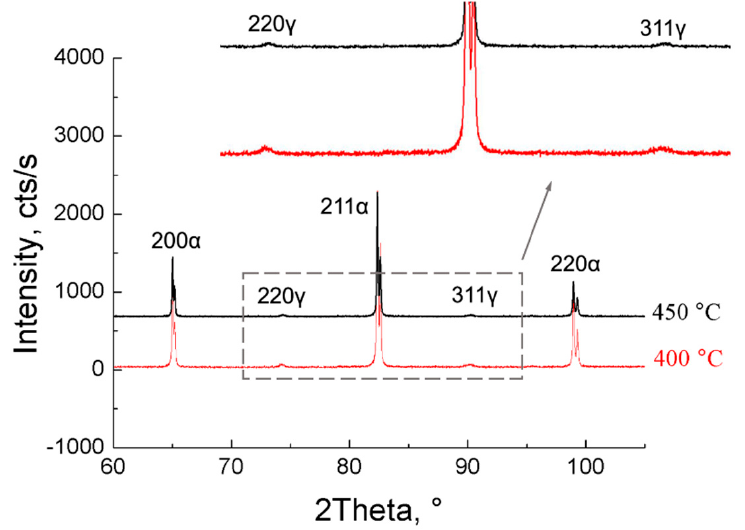
Figure 11. X ‐ ray diffractograms after holding at 400 and 450 °C for 900 s (15 min).